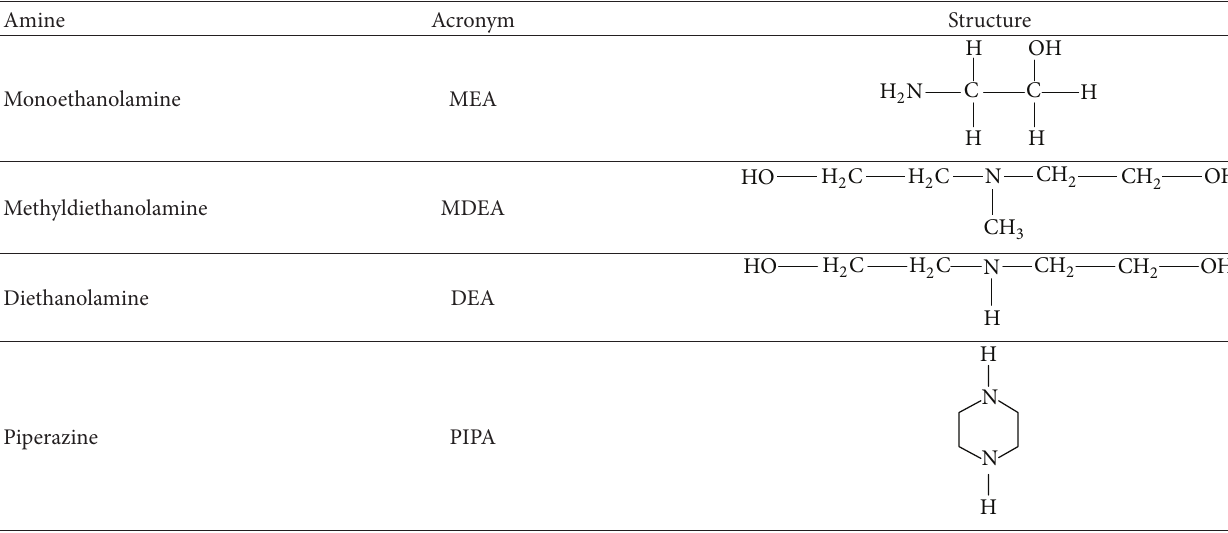
Figure 2: Conceptual scheme for CO 2 absorption using amine-based chemical absorption. Table 1: Chemical structures of commonly used